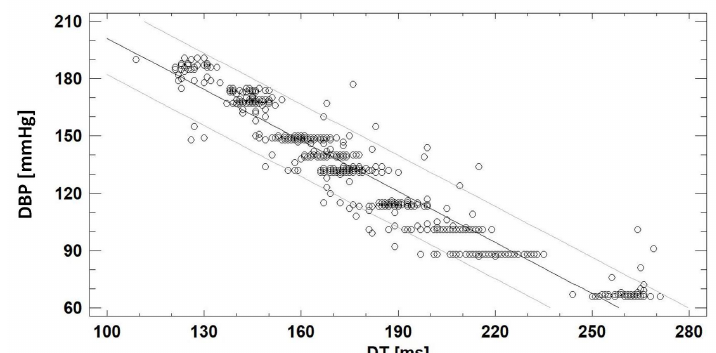
Figure 6. Capability of the model (Equation (4) to describe the measured DBP as a function of DT. The solid line indicates the mean value, while the dashed lines mark 95 % confidence